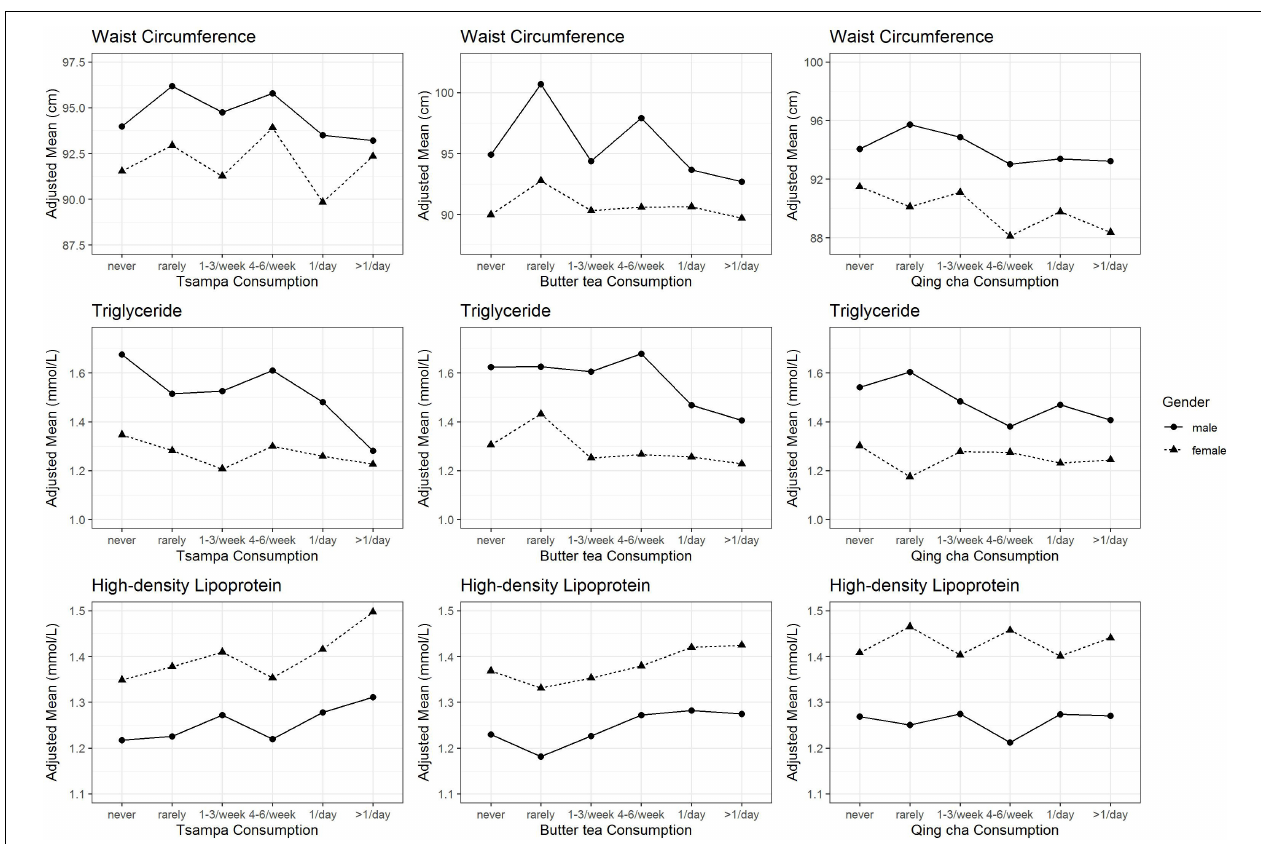
FIGURE 2 | Adjusted mean waist circumference, triglyceride, and high-density lipoprotein according to the frequency of Tsampa, butter tea, and Qing cha consumption. Mean values for waist circumference, triglyceride, and high-density lipoprotein were adjusted for age, marital status, educational level, annual household income, smoking status, alcohol intake, physical activity, and consumption of red meat, dairy products, eggs, fresh vegetables, and